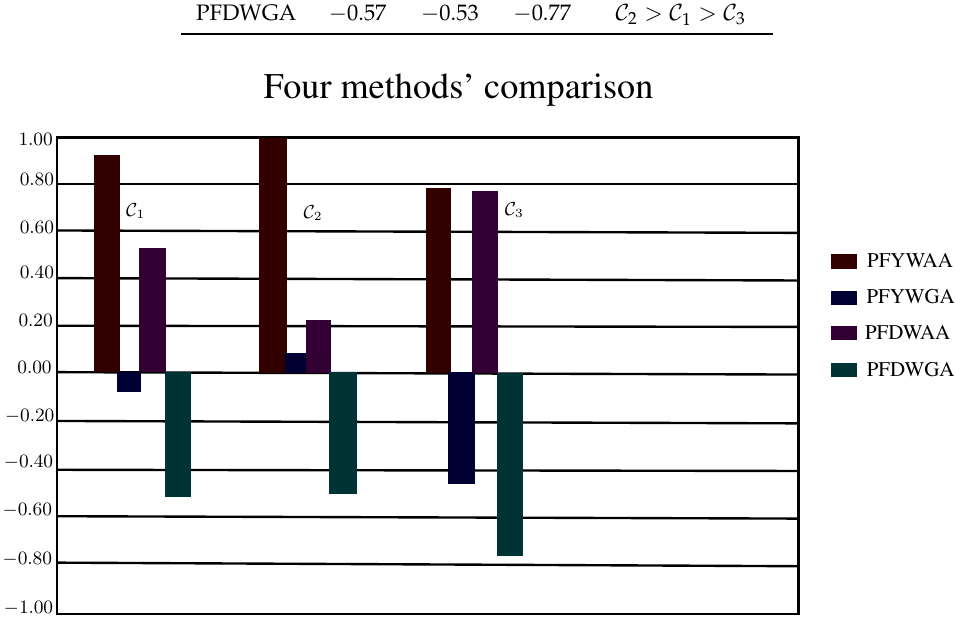
Figure 3. Four methods’ comparison. Table 6. Comparison analysis for Section 5.2 with Pythagorean fuzzy Dombi weighted averaging